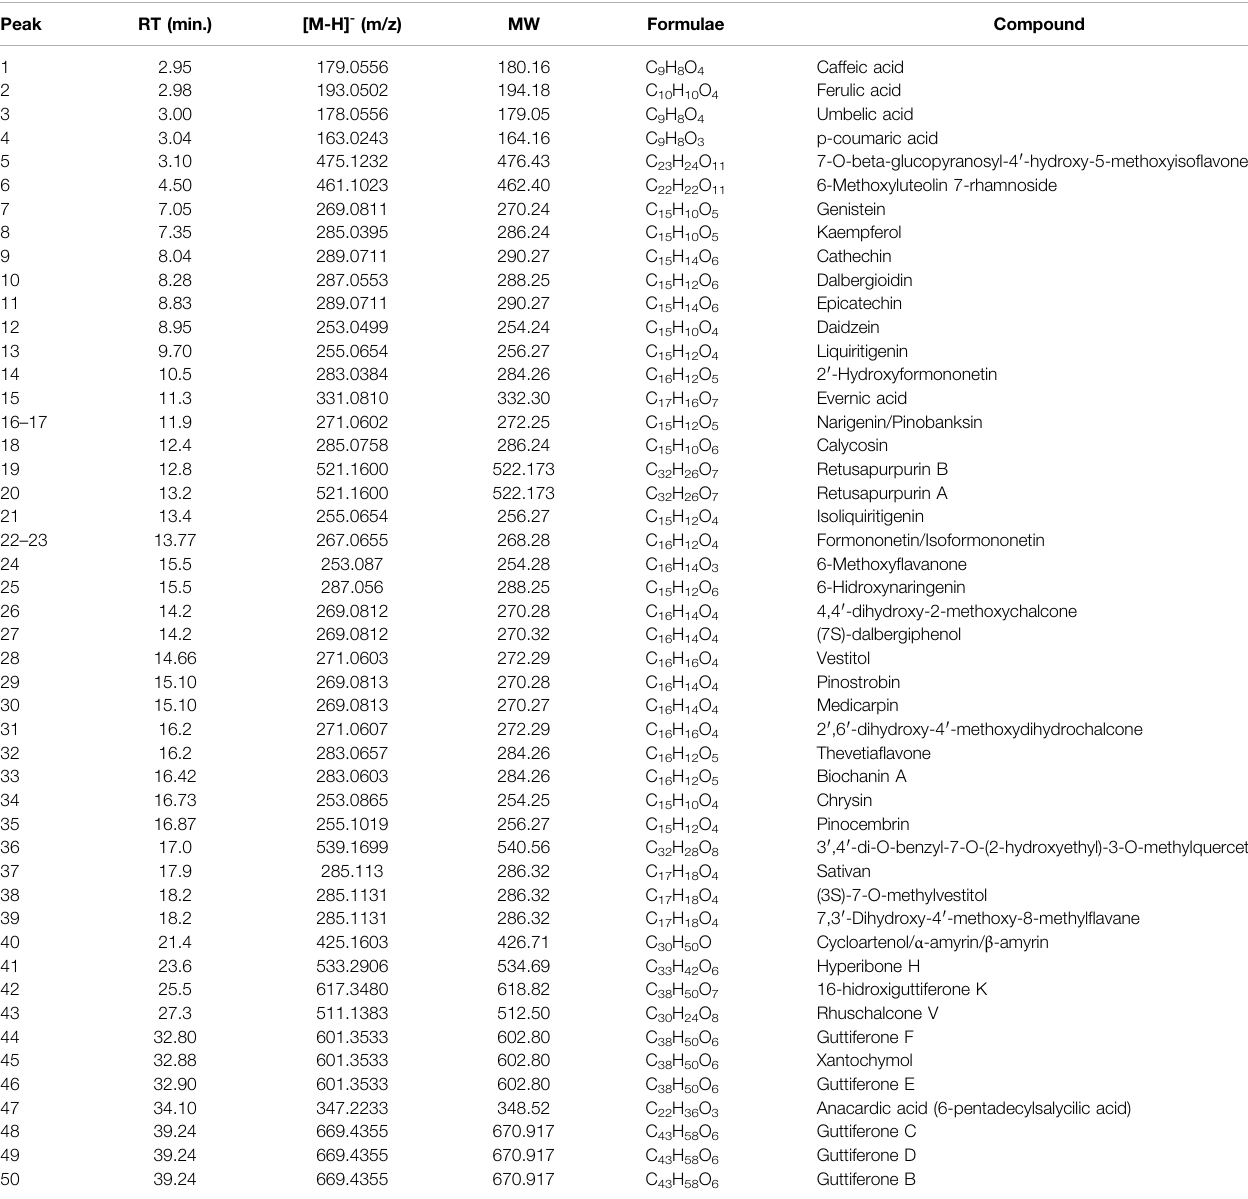
TABLE 2 | Identi fi cation and con fi rmation of some markers of the EABRP using LC-ESI- Orbitrap-FTMS. Peak RT (min.)